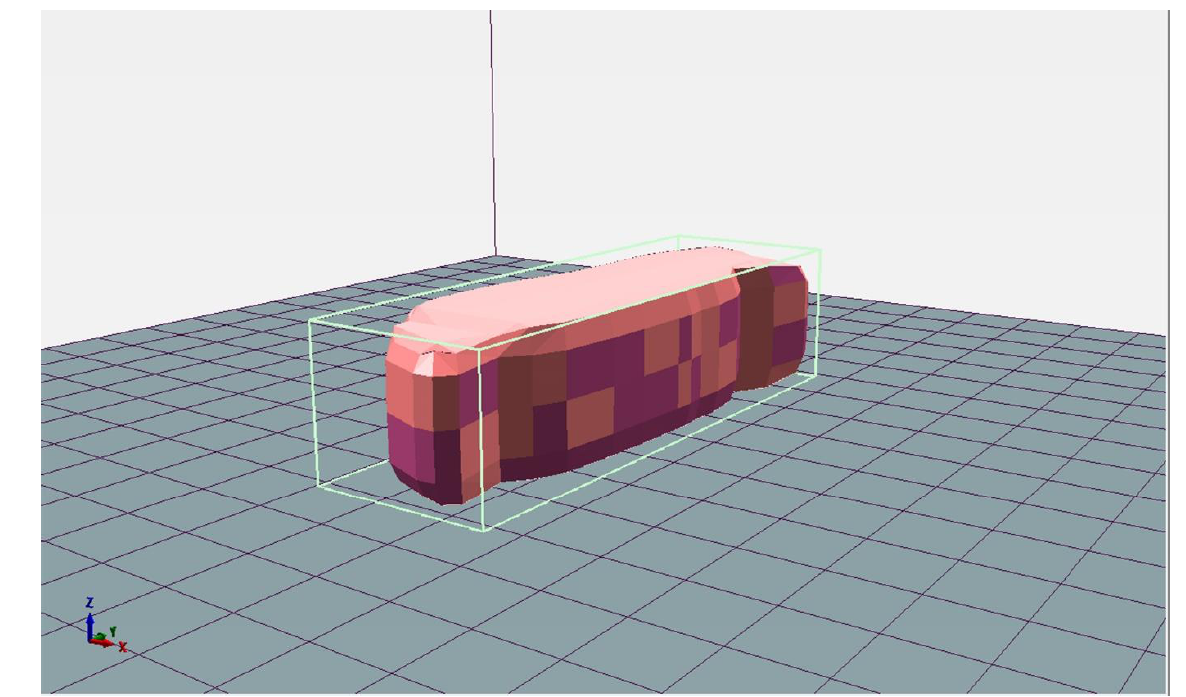
Figure 1. 3D model of meat mimics.